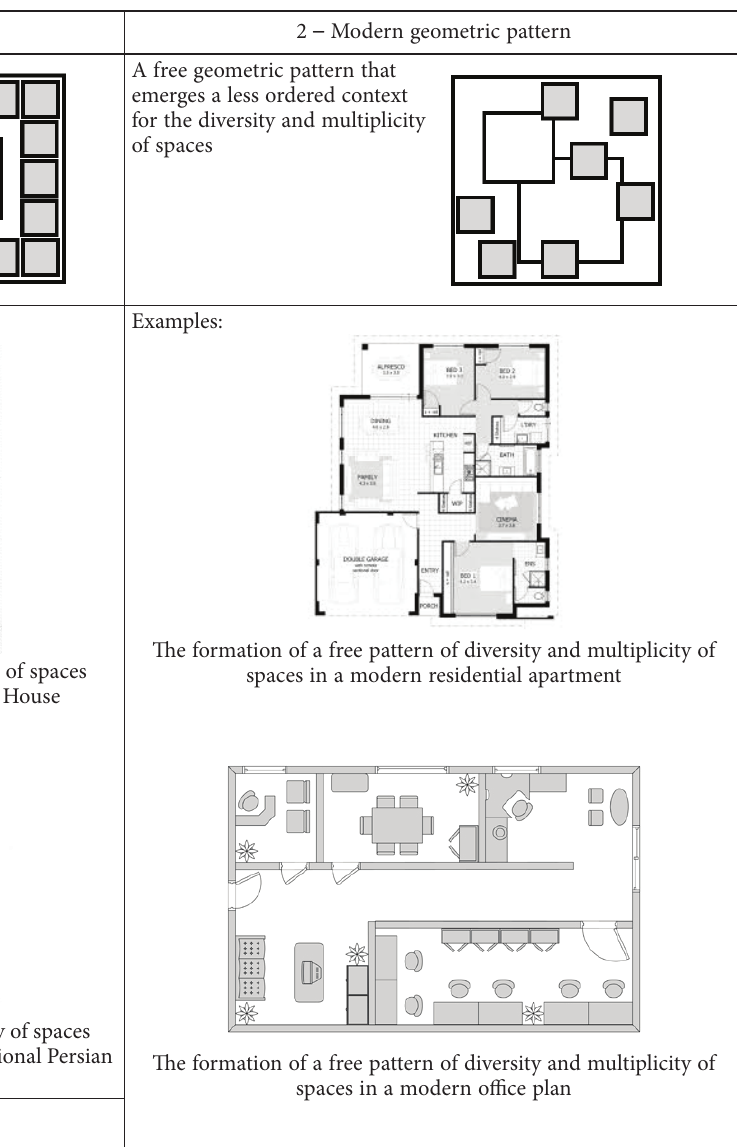
Table 3. Emerging the diversity and multiplicity of spaces in the traditional and modern geometric patterns